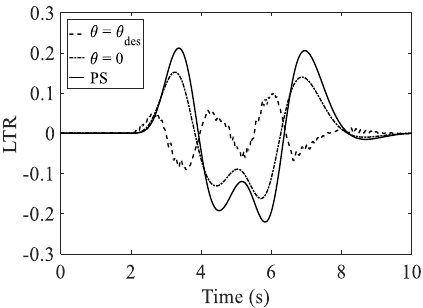
Figure 21. Lateral load transfer ratio.